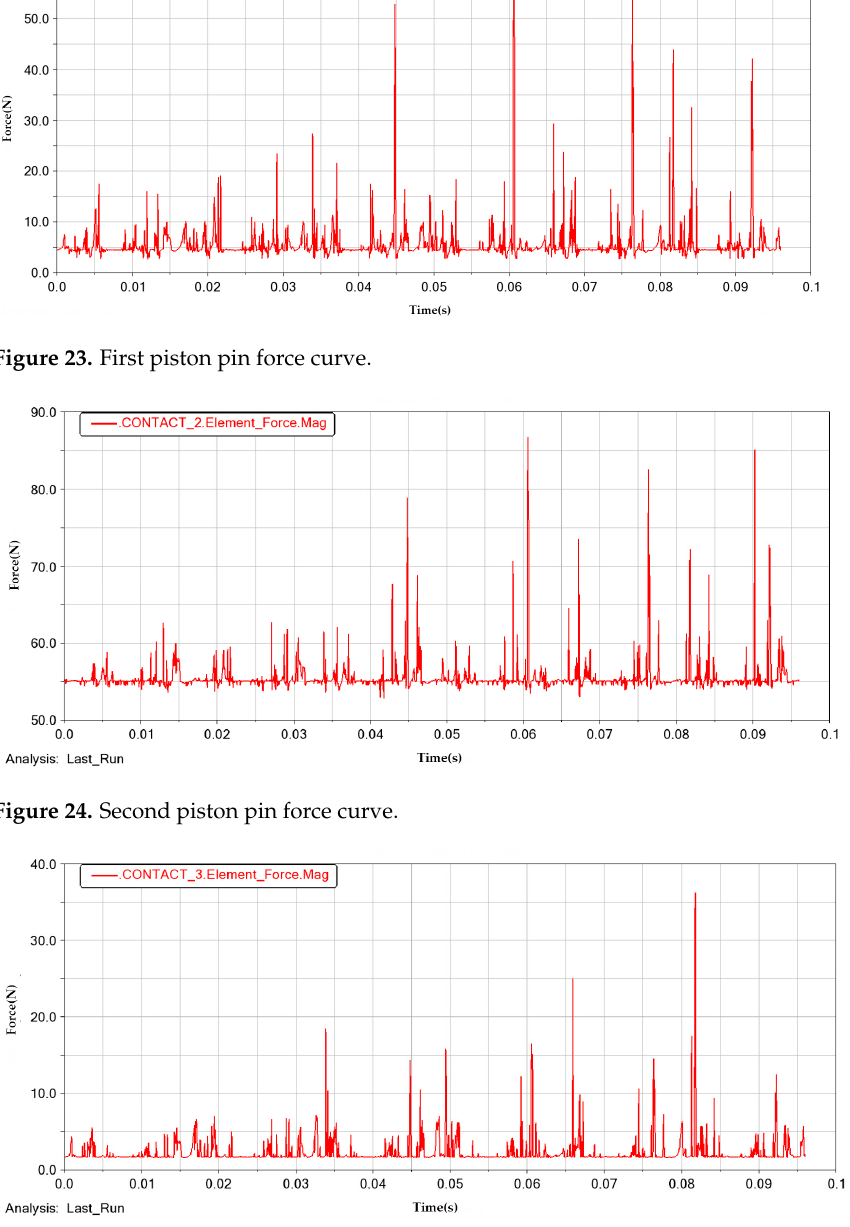
Figure 25. Third piston pin force curve.